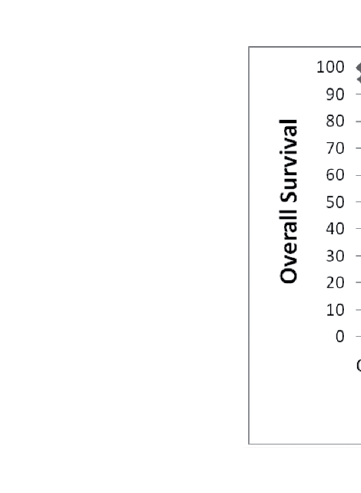
Figure 1 – survival curve.